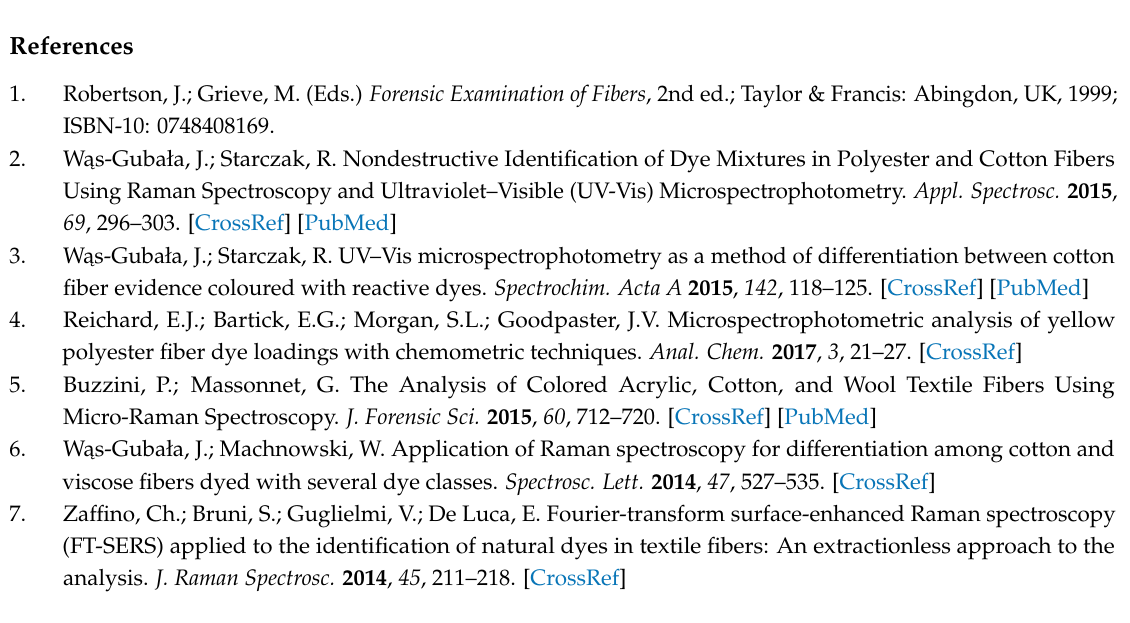
Supplementary Materials: The following are available online, Tables S1–S3. Table S1: Overview of the extraction procedures of disperse dyes from dyed polyester fibers; Table S2: Overview of chromatographic methods described in the literature [12–21] for the identification of disperse dyes extracted from polyester fibers (chromatographic conditions); Table S3: Overview of chromatographic methods described in the literature [12–21] for the identification of disperse dyes extracted from polyester fibers (selected qualification and quantification